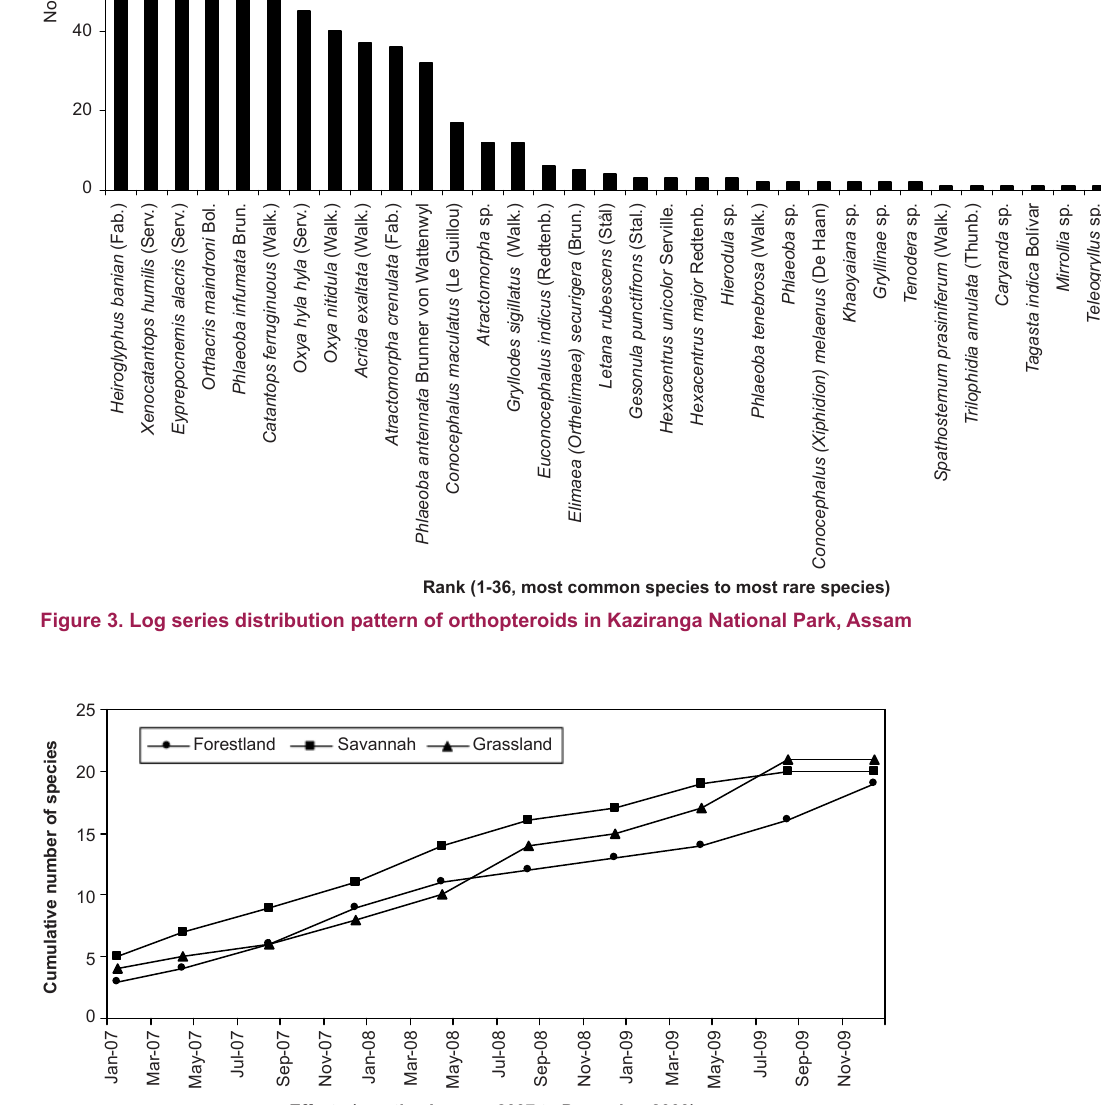
of orthopteran species confirmed the log series distribution pattern (Fig. 3) thereby giving creditability to the Fisher’s α values. Simpson’s diversity index, ‘λ’, gives high value for grasslands (8.4), followed by savannah (7.56) and the forestland (7.19).